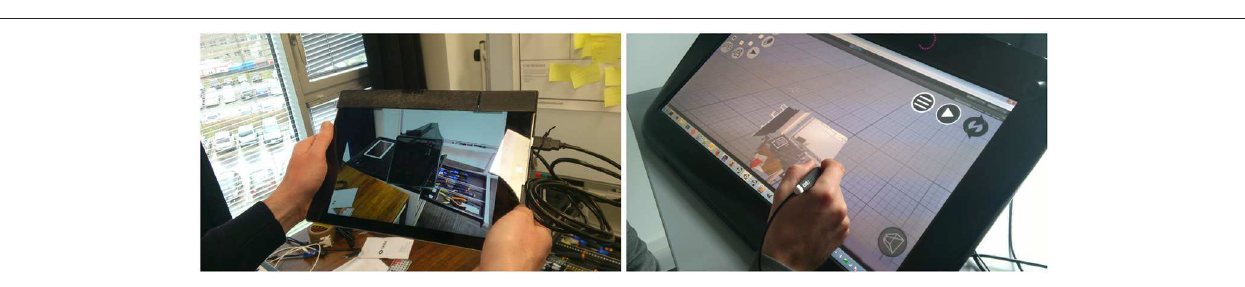
virtual interpenetration between the follower’s point of view and the guide’s virtual